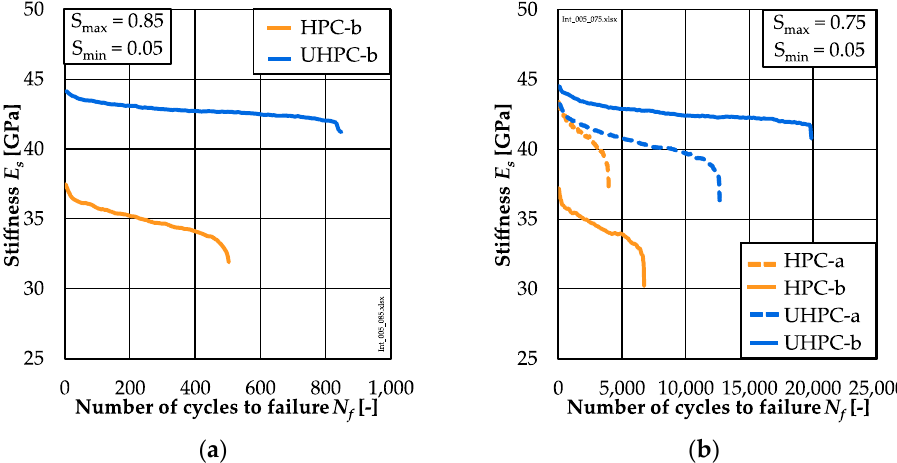
Figure 6. Averaged stiffness development of HPC and UHPC concretes for S max = 0.85 ( a ) and S max = 0.75 ( b ).